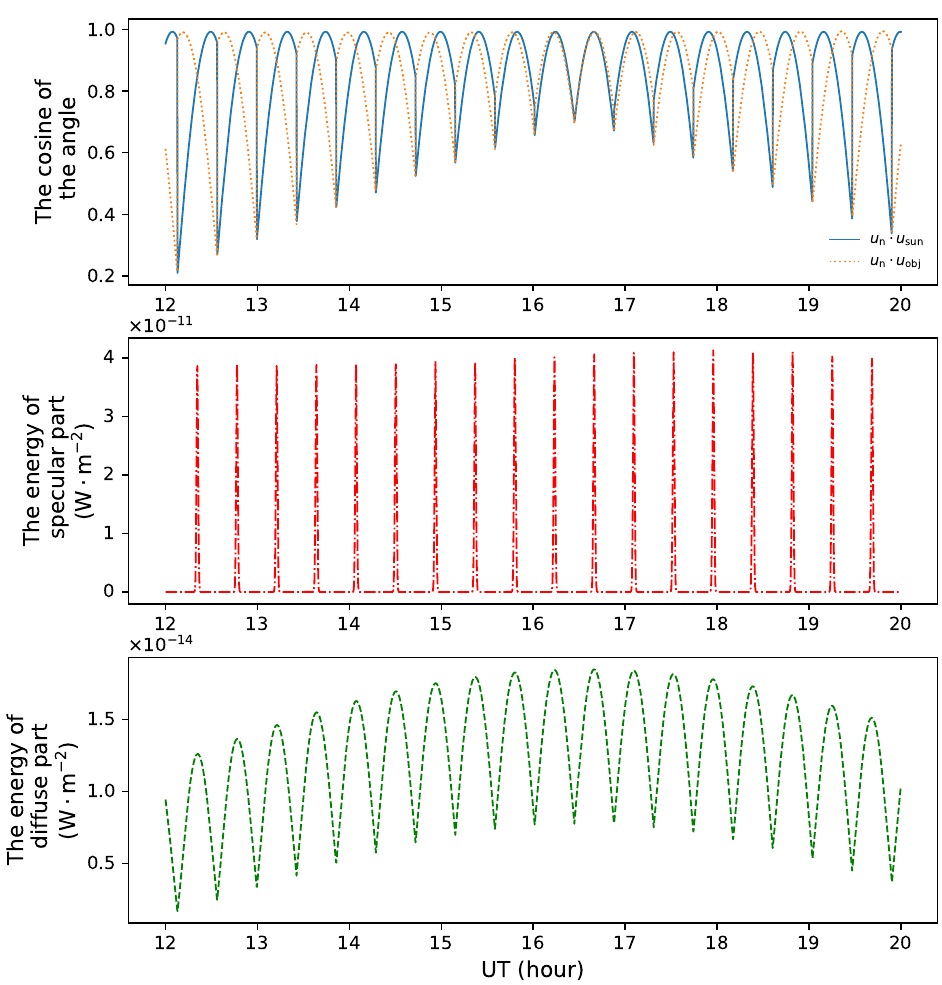
Figure 5. Synthetic light curves for different attitudes.